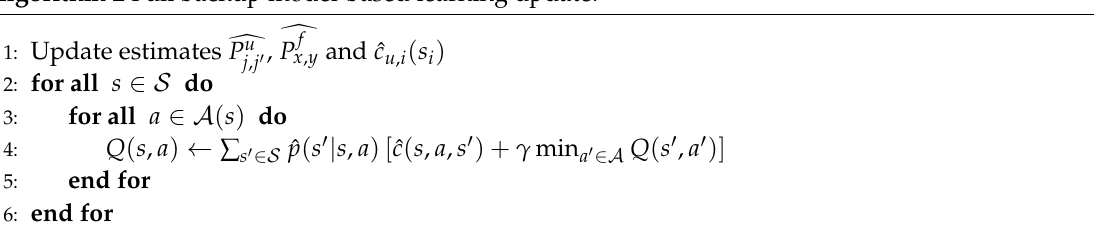
Algorithm 2 Full backup model-based learning